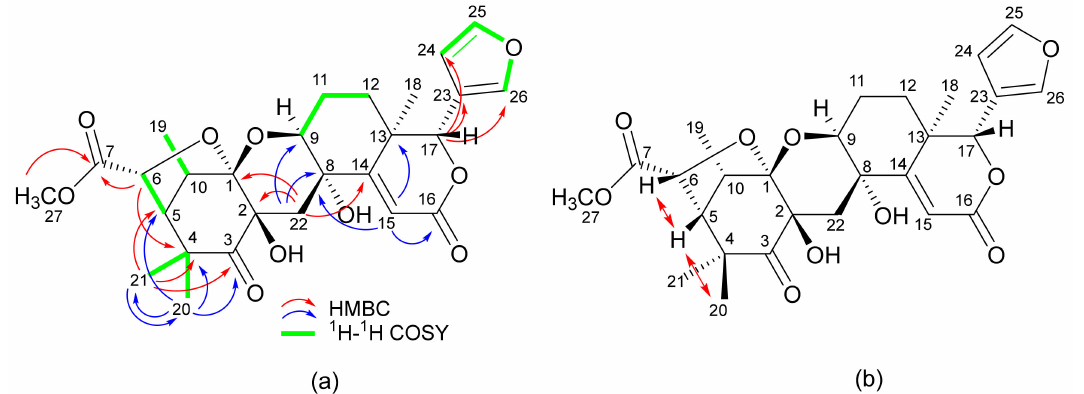
Figure 2. ( a ) 1 H- 1 H COSY and HMBC and ( b ) NOESY correlations for compound 1